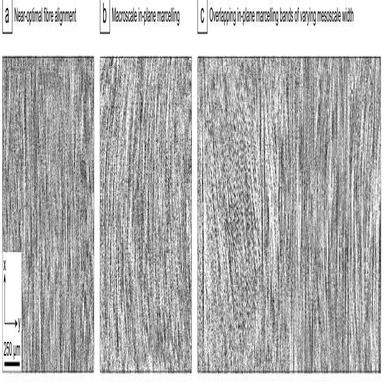
Examples of the two marcelling regimes observed in x-y tomograms: (a) region with near-optimal fibre alignment; (b) region with macroscale marcelling; (c) region with overlapping marcelling bands of varying mesoscale width.